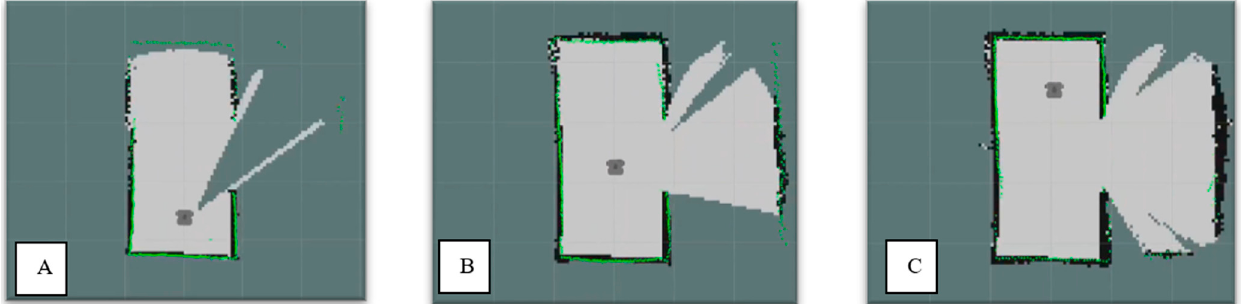
Figure 9. RViz map of test case 2 at positions ( A – C ) where the mobile robot travels along a plane mirror.